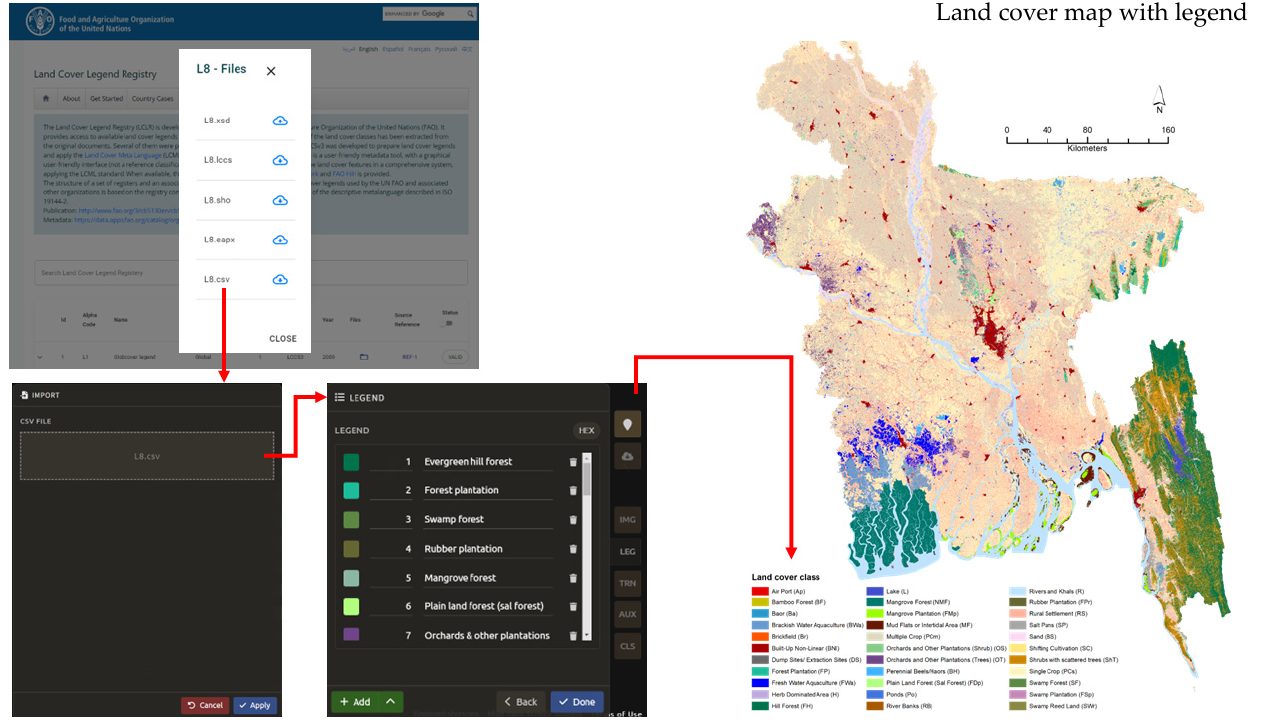
Figure 7. Land cover legend registry connectivity to SEPAL for land cover mapping.